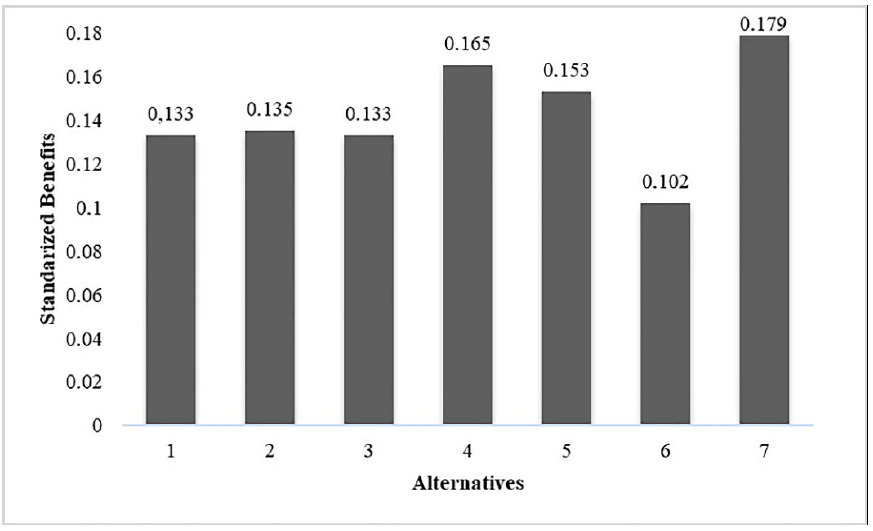
Figure 5. Ranking of alternatives by implementing the AHP model.